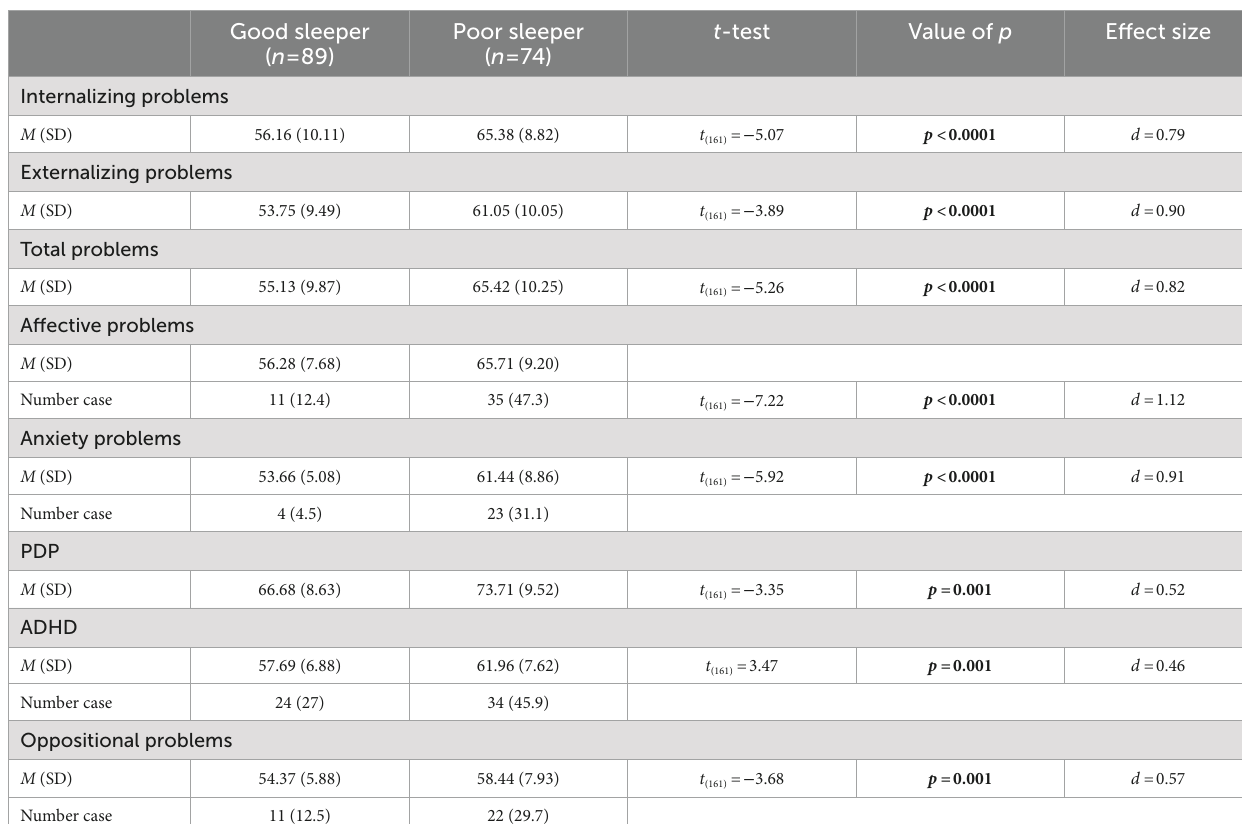
TABLE 3 Differences in DOS and Summary Scale of CBCL between poor and good